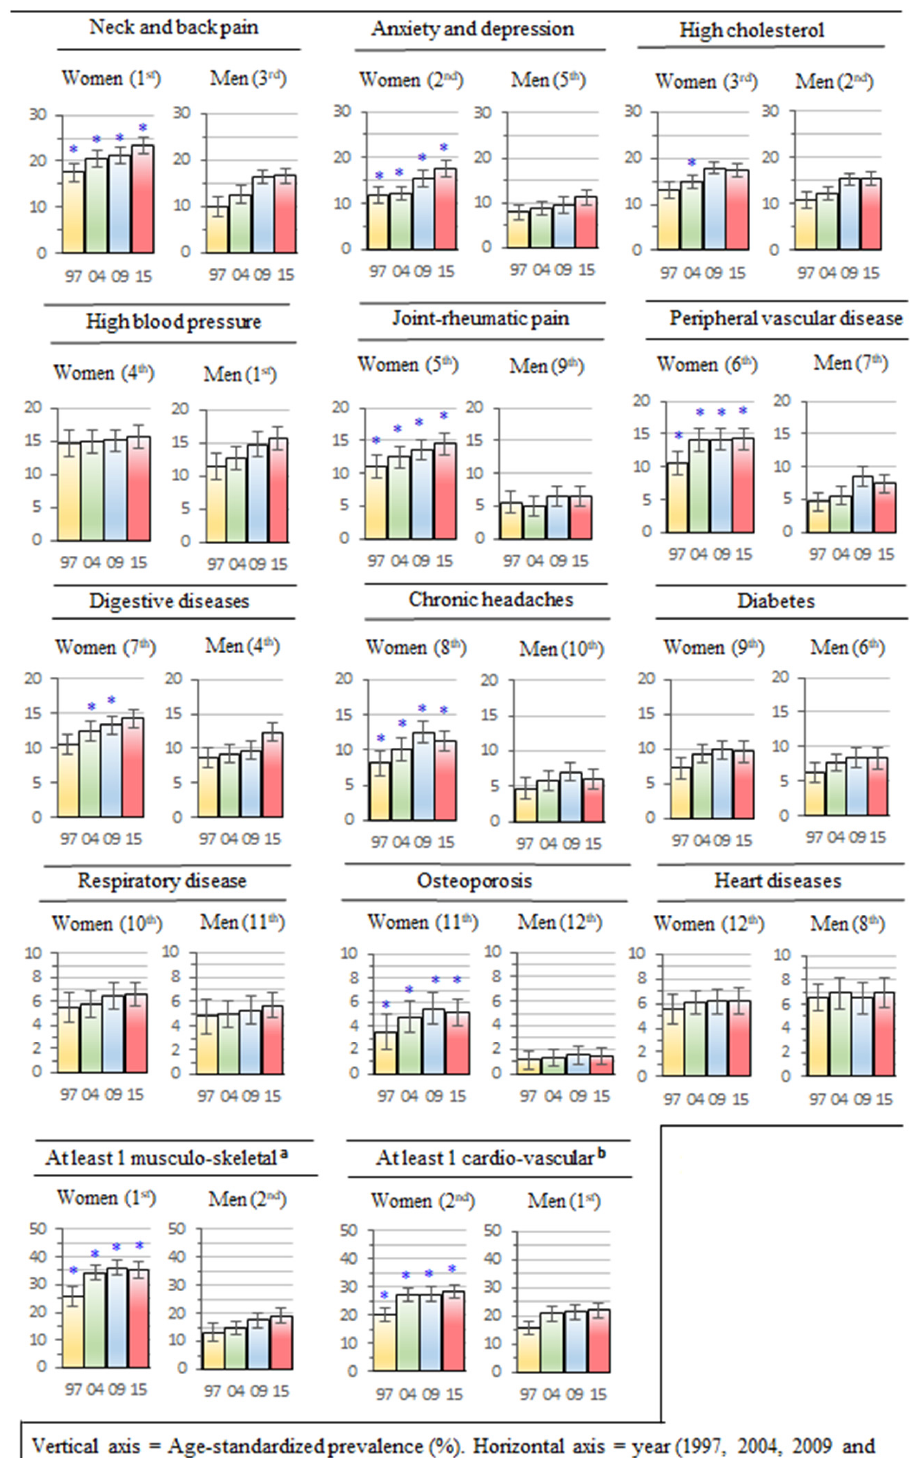
Figure 1. Prevalence of selected chronic morbidity in the Canary Health Survey (1997, 2004, 2009 and